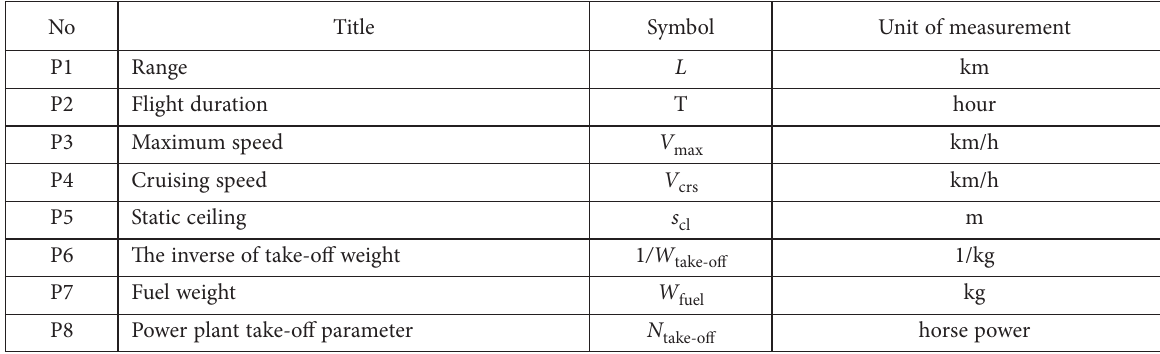
Table 1. Parameters of UAV